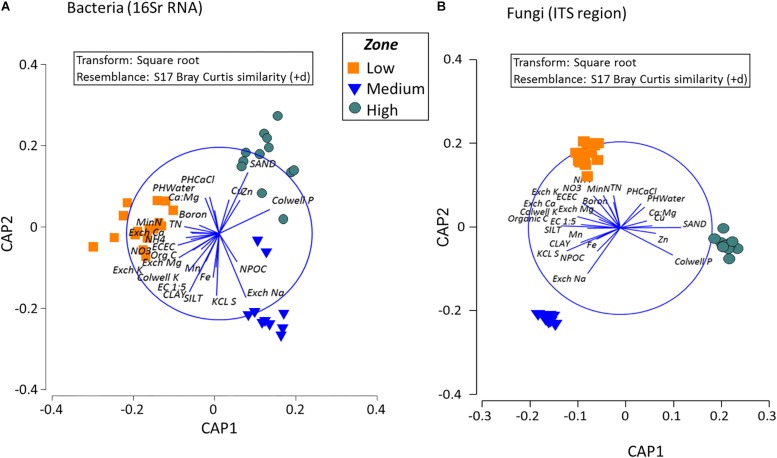
Composition of bacterial and fungal communities in the surface soils in the different rotundone-based soil zones. Canonical analysis of principle (CAP) ordination for (A) Bacteria and (B) Fungi, constrained by zone based on the Bray–Curtis similarity distance metrics. Vectors in the circle represent fitted values of soil properties showing Pearson correlations r > 0.50.